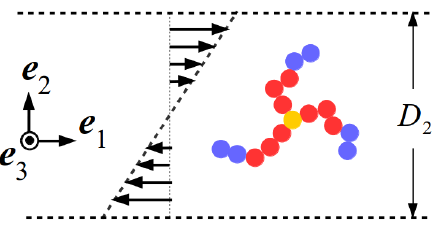
Figure 1. Schematic illustration of the simulation setup, demonstrating the shear (ˆ e 1 ), gradient (ˆ e 2 ) and vorticity (ˆ e 3 ) directions of planar, Couette flow. Yellow, red and blue spheres correspond respectively to the star core, solvophilic (A type) monomers and solvophobic (B type)